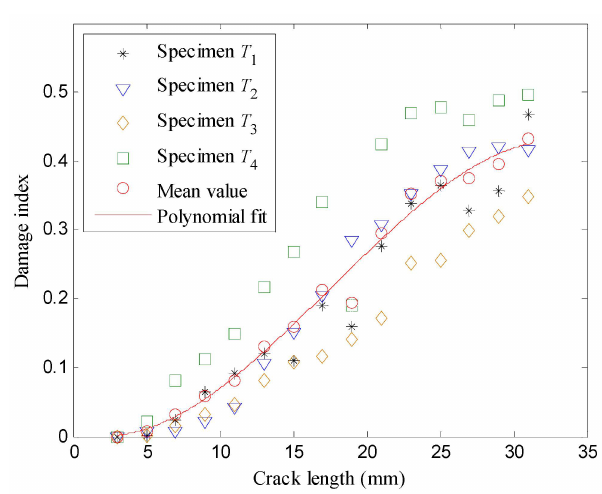
Figure 11. The relationship of damage index versus the crack